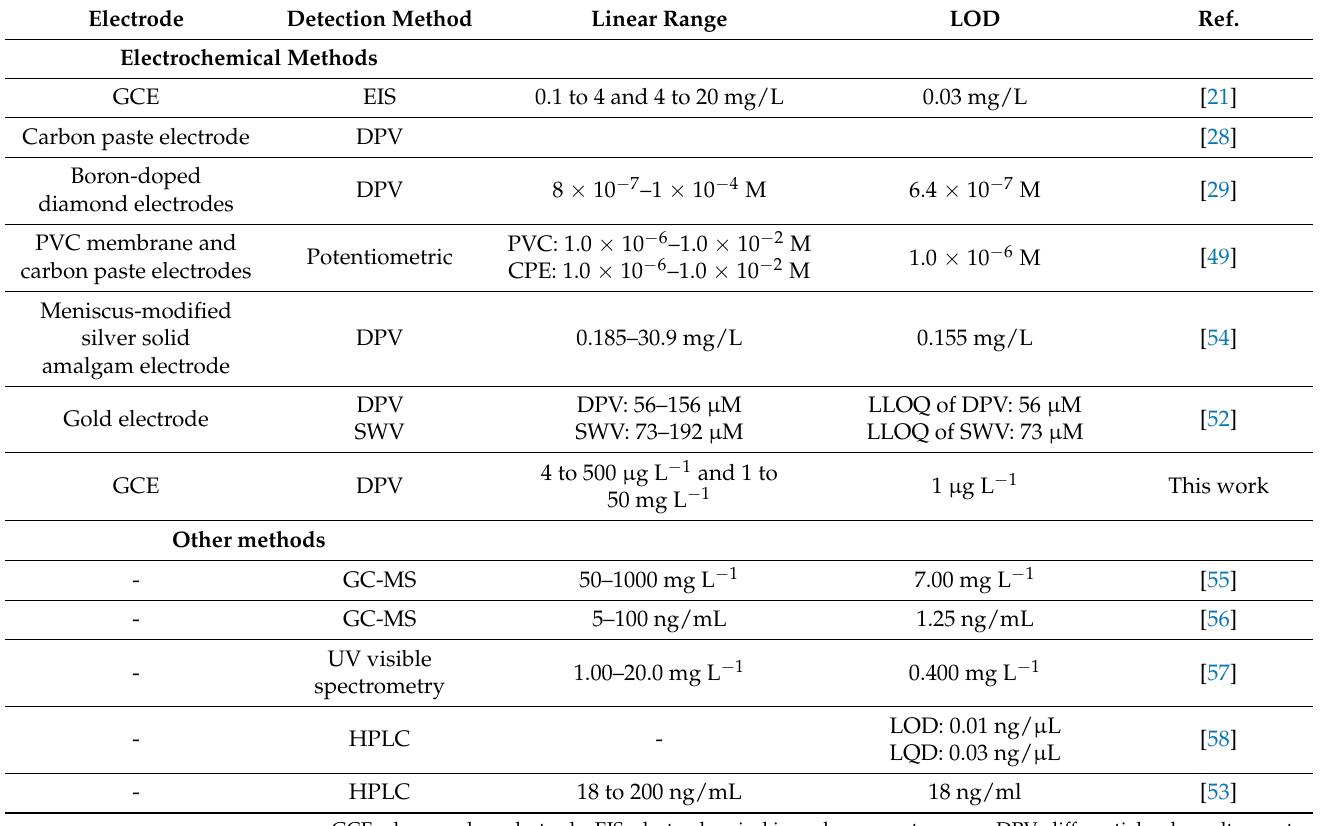
Table 1. Comparison of nanobiosensor features and analytical performance to others published about alprazolam